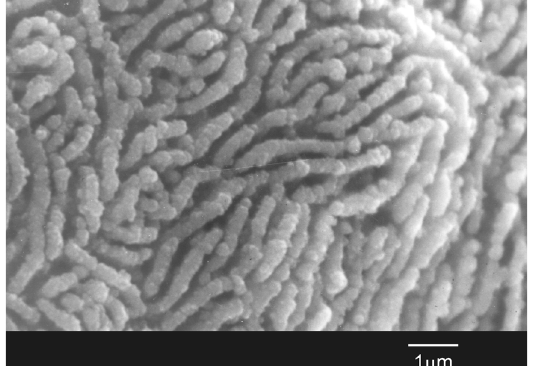
Figure 1. Transformation of the bioeutectic ® material after soaking for two weeks in SBF into a structure similar to hydroxyapatite porous